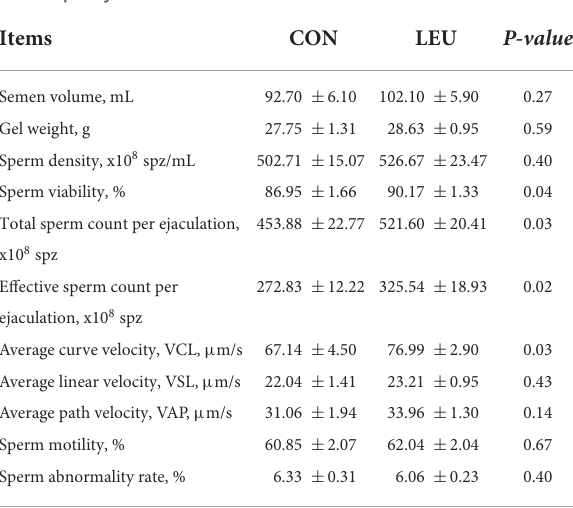
TABLE 5 Effect of dietary leucine supplementation on conventional semen quality of boars.